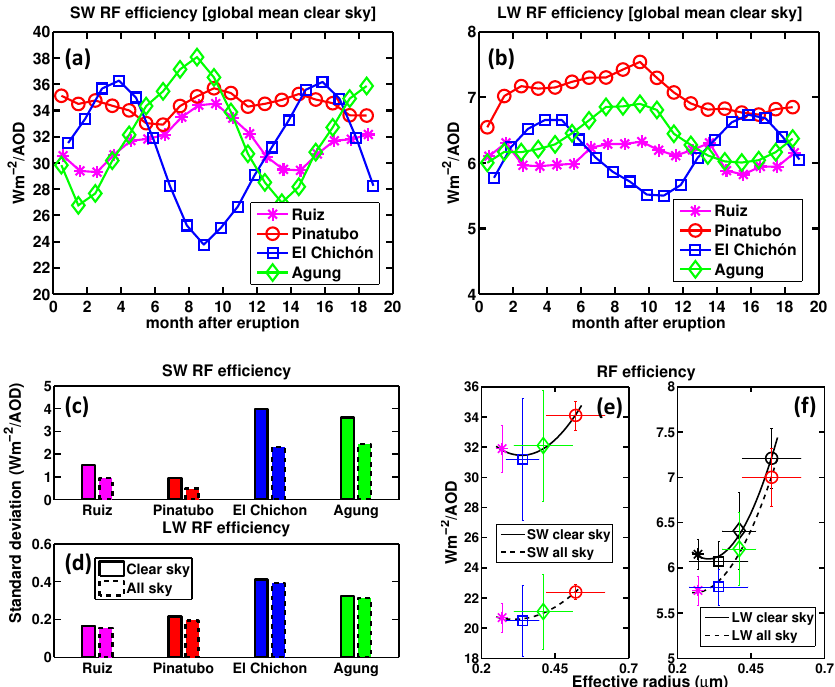
Figure 13. Panel ( a ) time series of the calculated shortwave RF efficiency, defined as the absolute value of globally averaged SW RF normalized to the volcanic aerosol optical depth (Wm ´ 2 /AOD). Panel ( b ) as in ( a ), but for the longwave RF efficiency. Panel ( c ) standard deviation of monthly mean values of the SW RF efficiency for Ruiz, Pinatubo, El Chichón and Agung cases, from left to right (Wm ´ 2 /AOD). Panel ( d ) as in ( c ), but for the LW RF efficiency. Panel ( e ) average values of the SW RF efficiency, as a function of the volcanic aerosol average effective radius (Wm ´ 2 /AOD); whiskers denote standard deviation values of monthly mean values of both efficiency and effective radius; the latter increases going from Ruiz, to El Chichón, Agung and finally to Pinatubo. Panel ( f ) as in ( e ), but for the LW RF